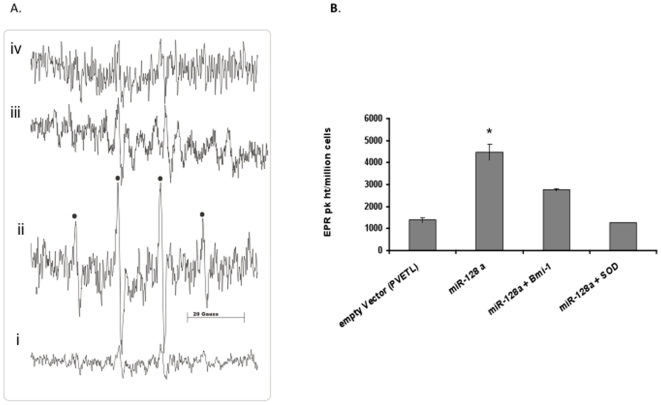
MiR-128a increases intracellular ROS by targeting Bmi-1.A) Increased superoxide radical formation in Daoy cells that were transfected with miR-128a as detected using EPR spectra of the DMPO-OH spin adduct (closed circles in (ii)). The spectra collected are a signal average of 15 scans. The 1∶2∶2∶1(closed circles) quartet signal seen is due to the formation of DMPO-OH. The cells treated with miR-128a have ∼3 fold increase in ROS signal intensity (ii) as compared to the empty vector (i). Co-transfection of cells with miR-128a and Bmi-1 resulted in a decreased ROS level compared to that of miR-128a alone (iii). The treatment of SOD in miR-128a-transfected cells abolished the signals showing that the radical formed is mainly superoxide (iv). B) The quantitative analysis of EPR peak height normalized to cell number. *p<0.05 miR128a vs. pVETL and miR-128a + SOD.